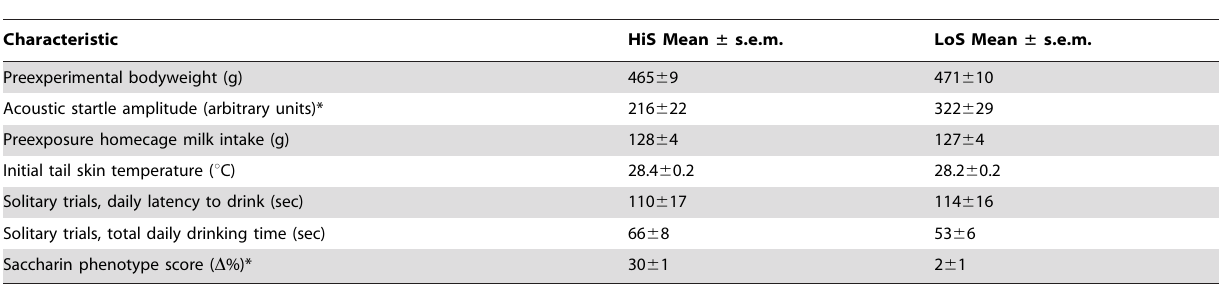
Table 2. Individual-level characteristics of HiS and LoS rats.